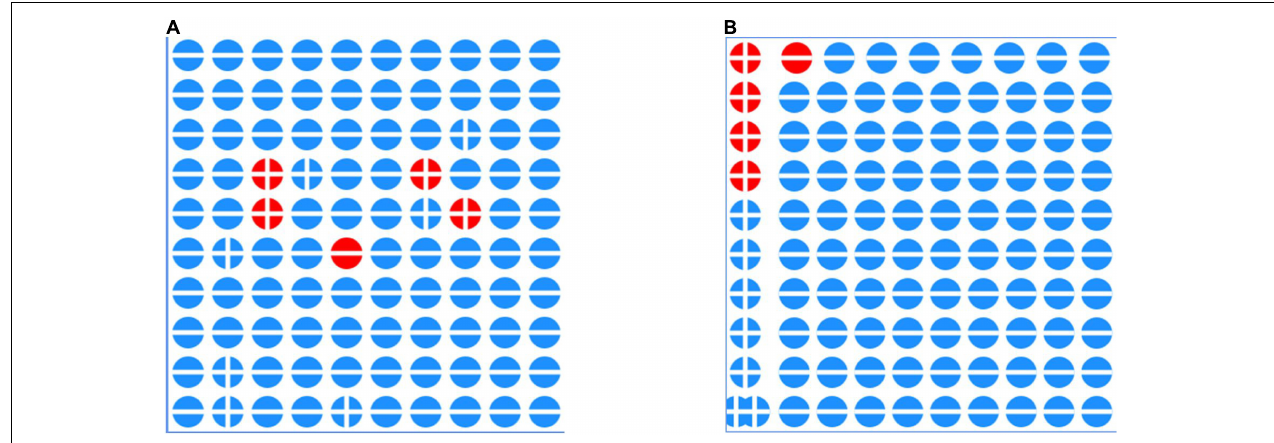
FIGURE 6 | (A) The icon array displays icons for 100 people tested as to whether they are HIV positive; unstructured data. (B) The same icon array has now been sorted grouping icons representing patients with/without the disease. (These illustrations are all from the dynamic webpage by the first author of this paper and T. Erickson: http://www.eeps.com/projects/wwg/wwg-en.html).